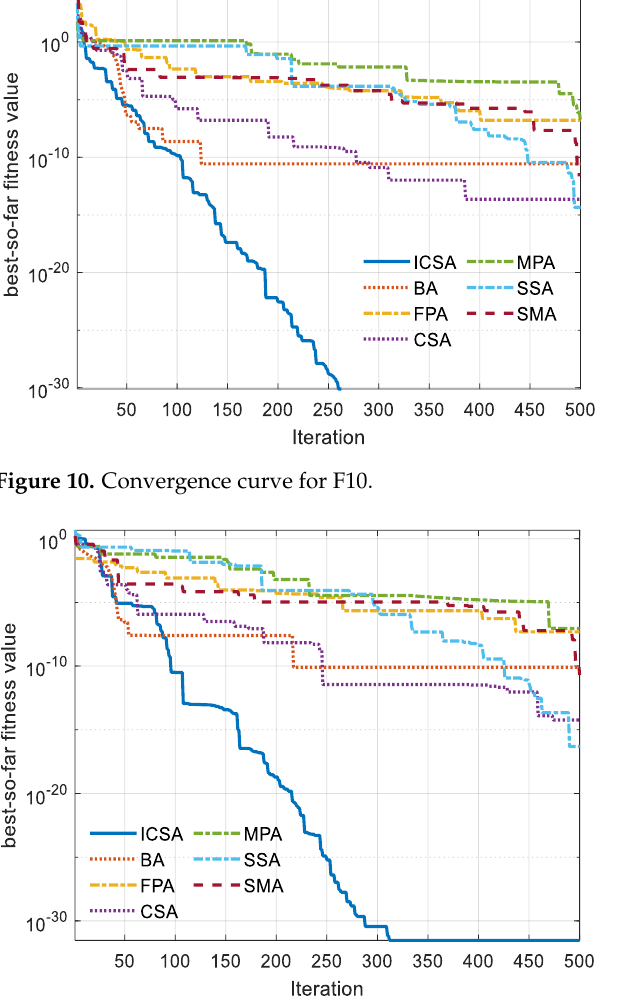
Figure 11. Convergence curve for F11.